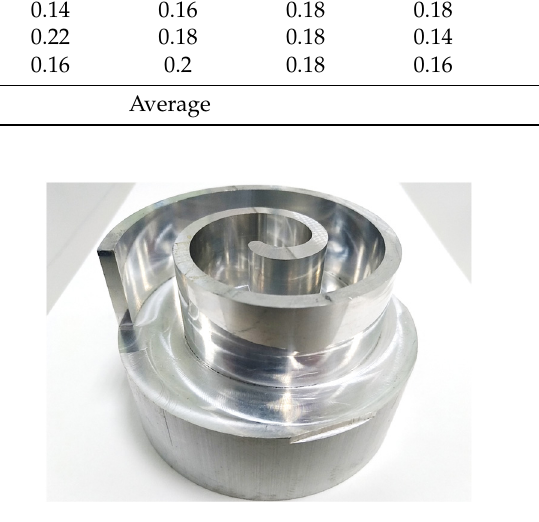
Figure 22. Scroll workpiece after the fine machining processes.